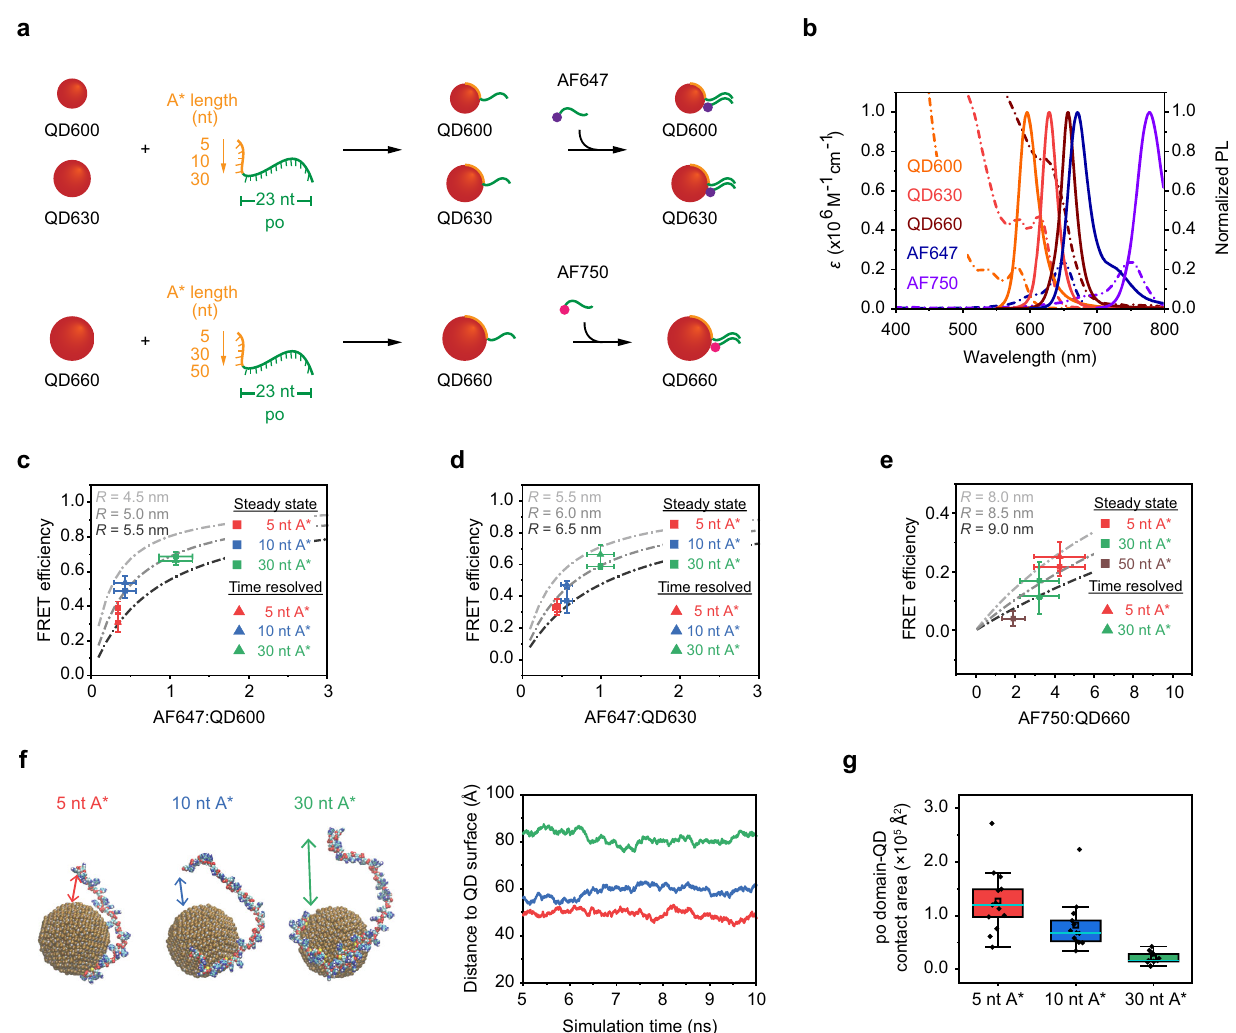
Fig. 2 | ssDNA wrapping hypothesis. a Schematic of ssDNA wrapping with chi- meric ssDNA containing 5 – 50nt A* and fi xed po domain (23nt) wrapping on QD600, QD630, and QD660, and QD valence validation using hybridization assay using AF647- or AF750-labelled complimentary strands. b Extinction coef fi cient (dash-dotted line) and photoluminescence (PL) spectra (solid line) of QD600, QD630, QD660,AF647and AF750. c – e FRETef fi cienciesasafunctionofacceptors calculated theoretically (gray dash-dotted curves, Eq. (5)), and from QD emission intensities (Supplementary Fig. 4) and QD emission decay curves (Supplementary Fig.6)of c QD600-AF647and d QD630-AF647and e QD660-AF750FRETpairs(the number of AF647 or AF750 per QD were calculated from decomposed absorption spectra (Supplementary Fig. 5)). f Representative MD simulation structures of